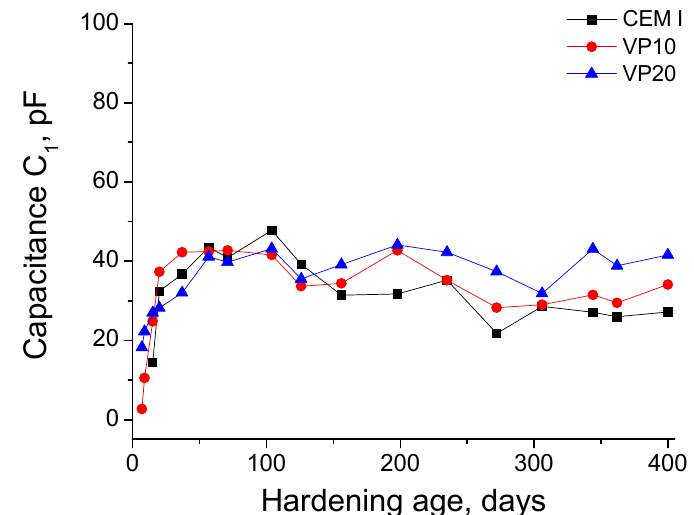
Figure 11. Impedance spectroscopy C 1 capacitance for the mortars studied.